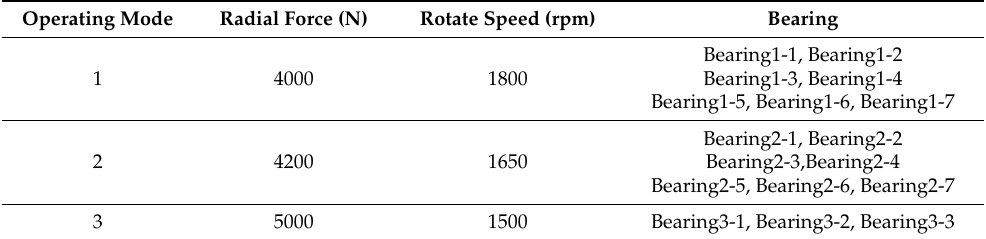
Table 2. distribution of bearings in 2012PHM